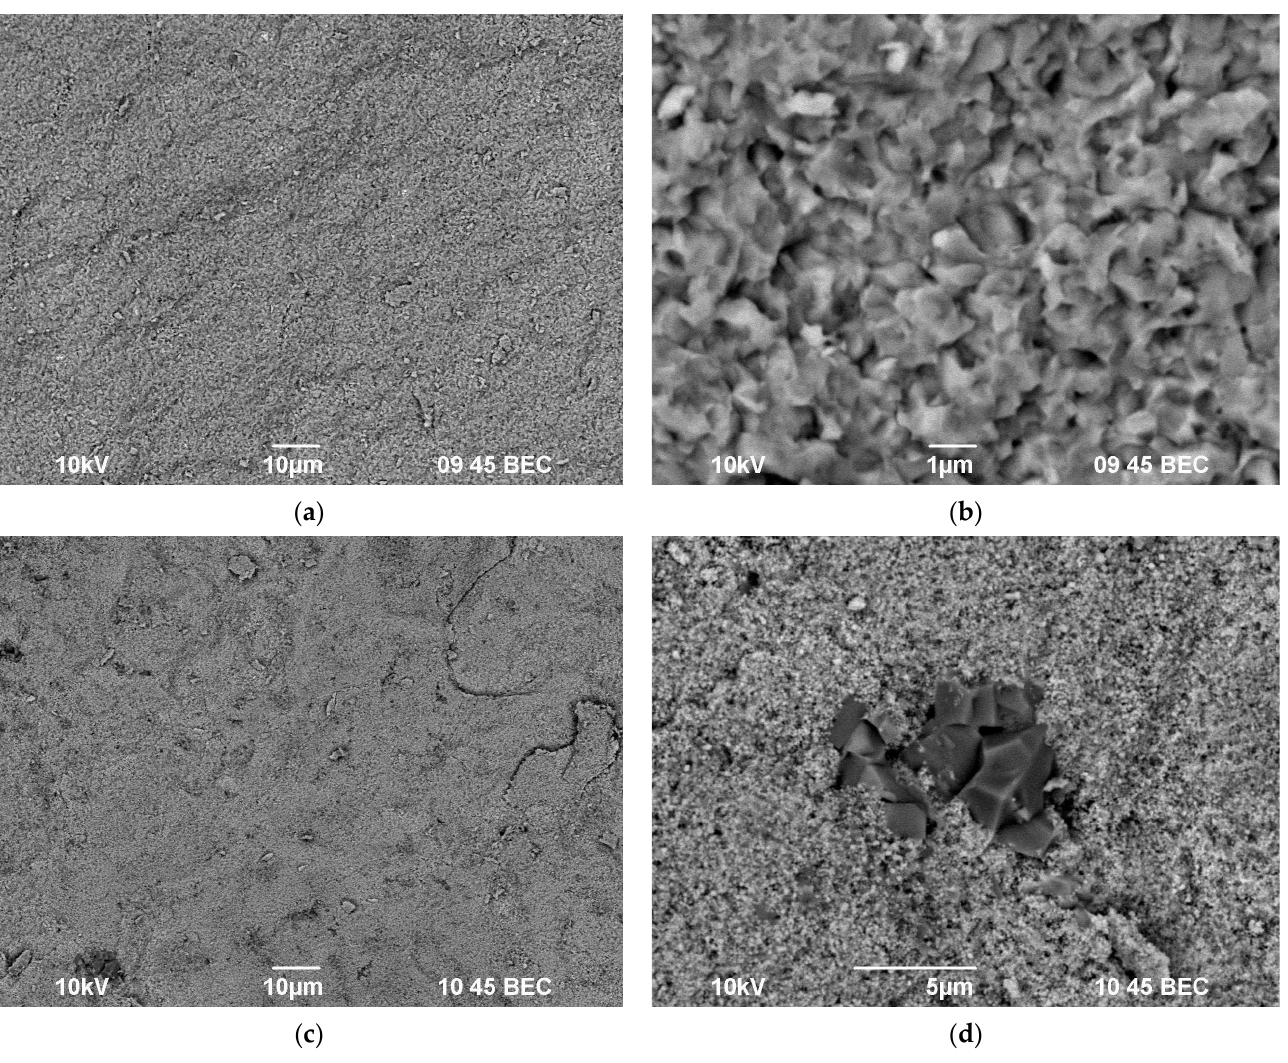
Figure 16 . Microstructure of Na 1-x Zr 2 (PO 4 ) 3-x (MoO 4 ) x ceramics with x = 0.1 ( a , b ) and x = 0.5 ( c , d ). SEM images of the fractures of sintered ceramic samples ( b , d ).